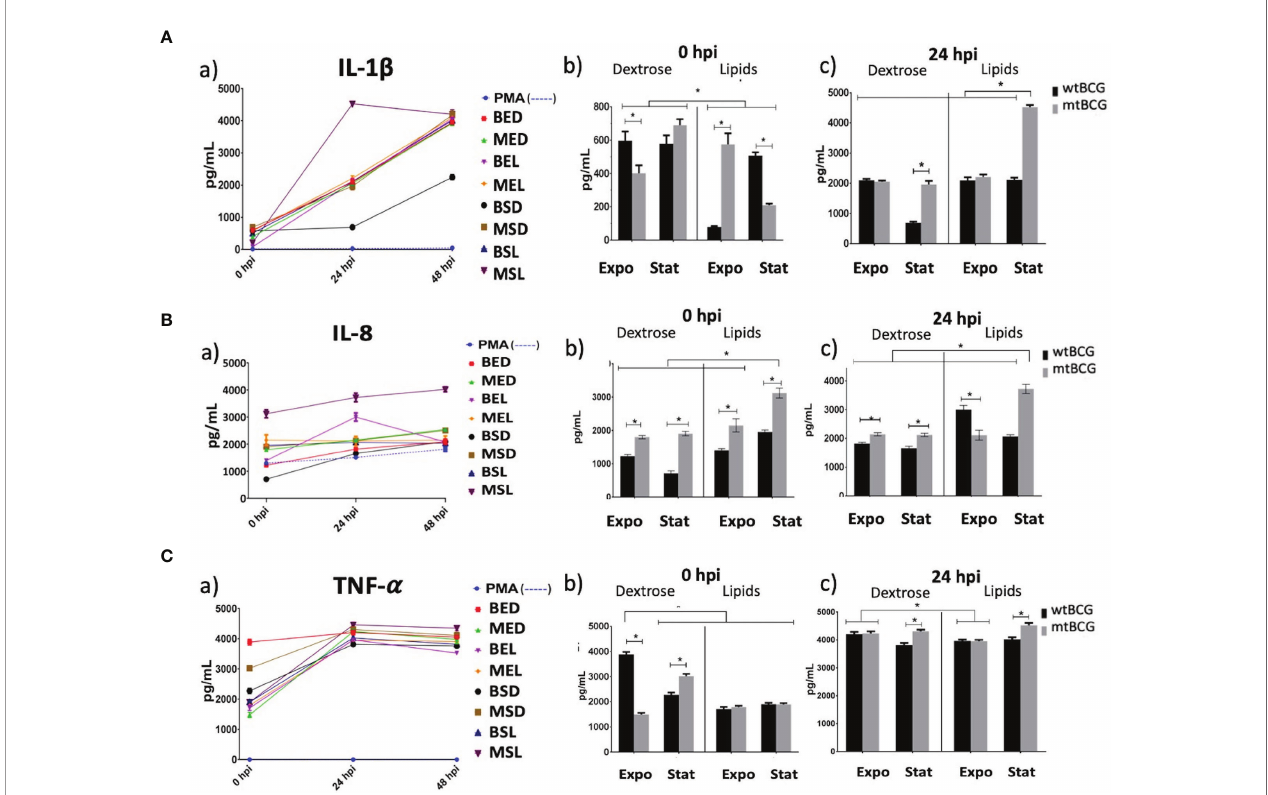
FIGURE 9 | Pro-in fl ammatory cytokine expression on THP-1 macrophages infected with M. bovis BCG strains. Expressions of IL-1 b , IL-8, and TNF- a ( A, B, C , respectively) were determined by ELISA in supernatants collected from different infection times. Signi fi cant changes in the concentrations of each cytokine are shown at 0 and 24 hpi (panels b, c ). In each determination, a positive control (cells overstimulated with 100 nM PMA) was used (dotted lines). All experiments were performed in triplicate using wtBCG or mtBCG cultured in dextrose or lipids during the exponential phase (BED, wtBCG dextrose; BEL, wtBCG lipids; MED, mtBCG dextrose; MEL, mtBCG lipids) or the stationary phase (BSD, wtBCG dextrose; BSL, wtBCG lipids; MSD, mtBCG dextrose; MSL, mtBCG lipids). *, p <